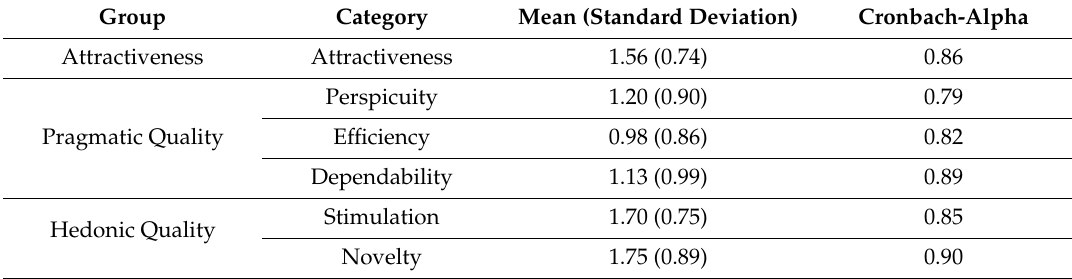
Table 6. User experience using